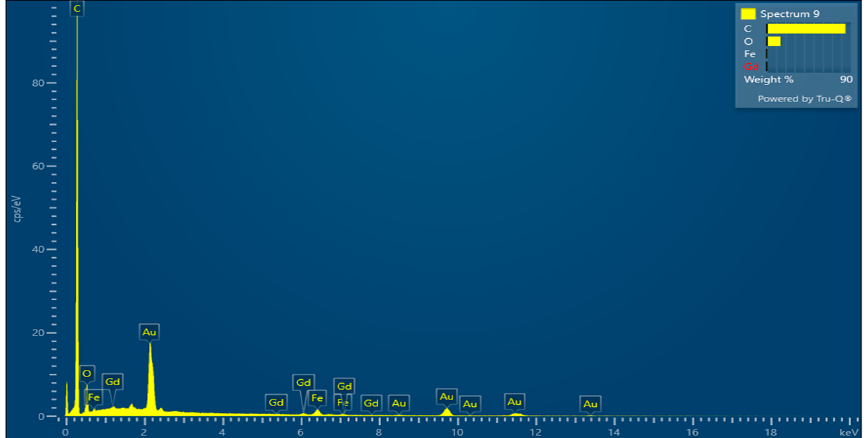
Figure 5. SEM-EDS spectra of Mag@Gd(OH) 3 . The high C detection did not come from the nanopar- ticles (see main text).